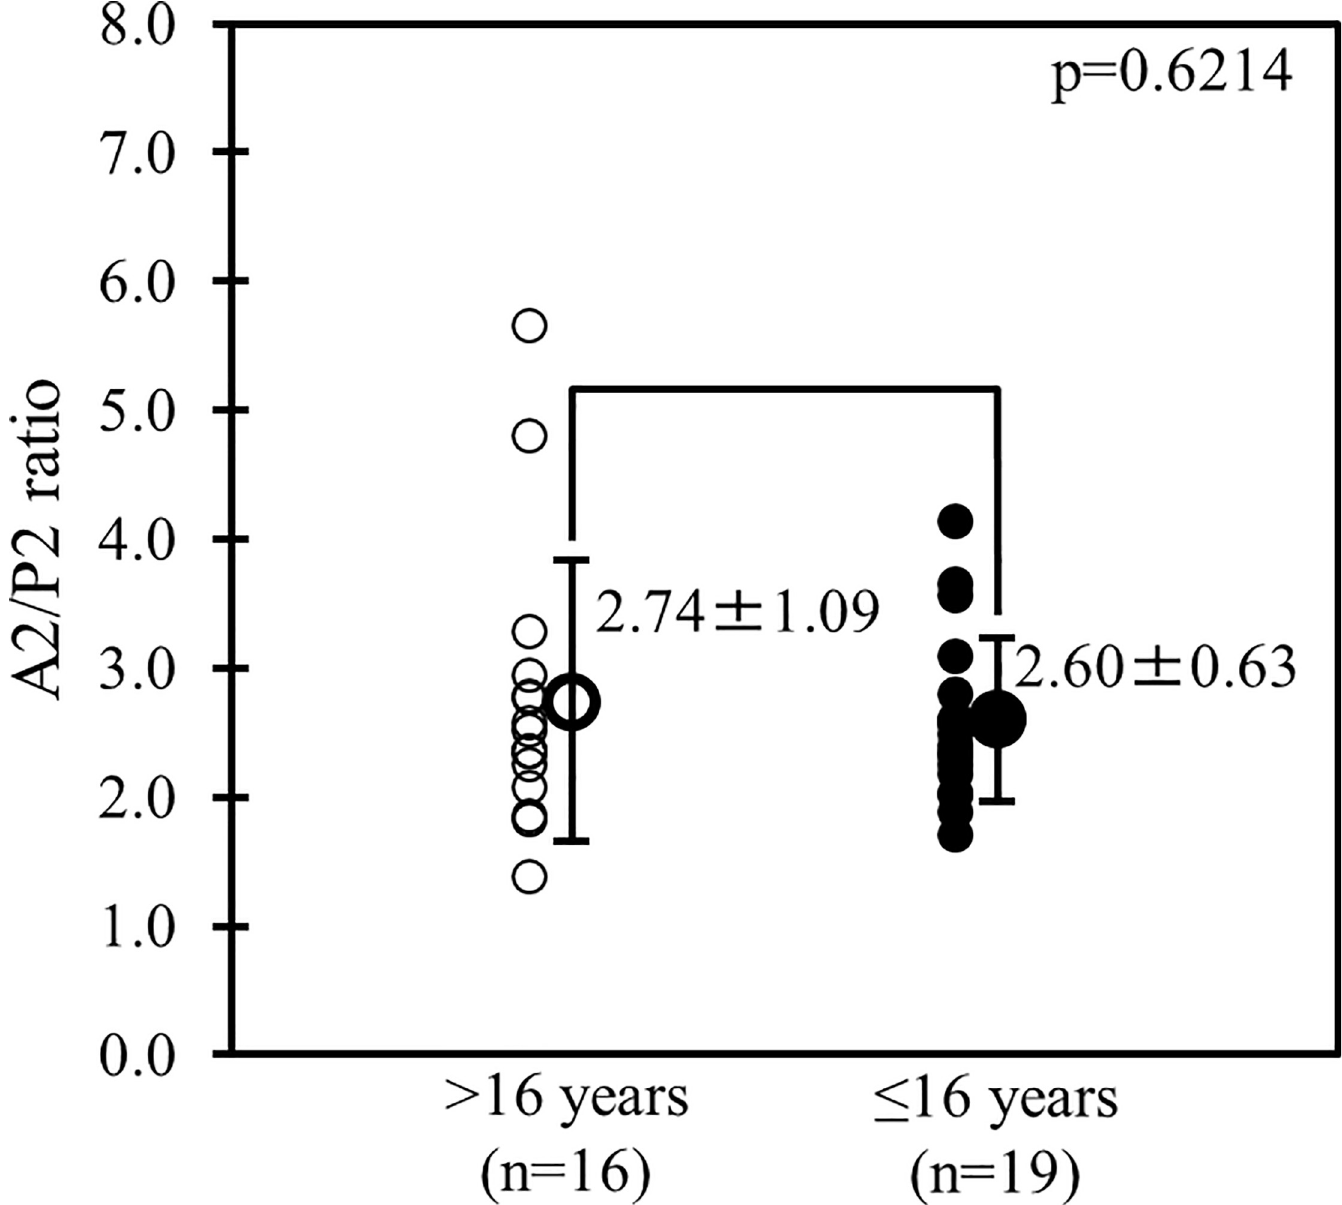
Fig 5. Comparison of the A2/P2 ratio in patients with pectus excavatum (PE). Comparison of the A2/P2 ratio between patients with PE older than 16 years and those 16 years or younger.